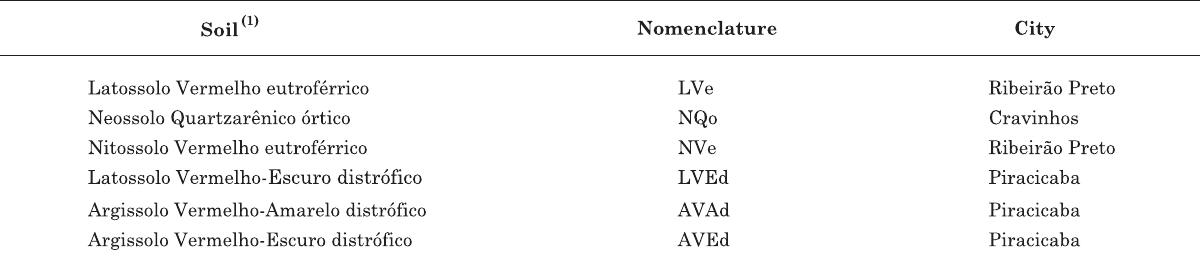
Table 1. Soil type, nomenclature, and counties of sample collections